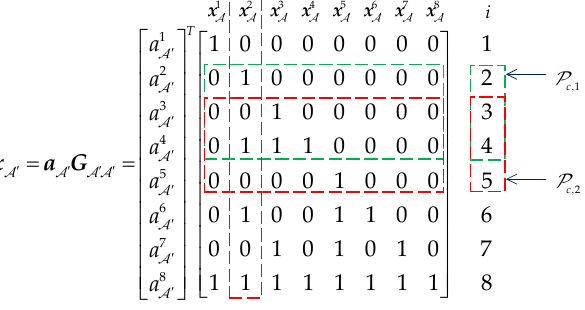
Figure 4. The e ff ect of P c on transformation x A (cid:48) = a A (cid:48) G A (cid:48) A (cid:48) . Figure 4. The effect of